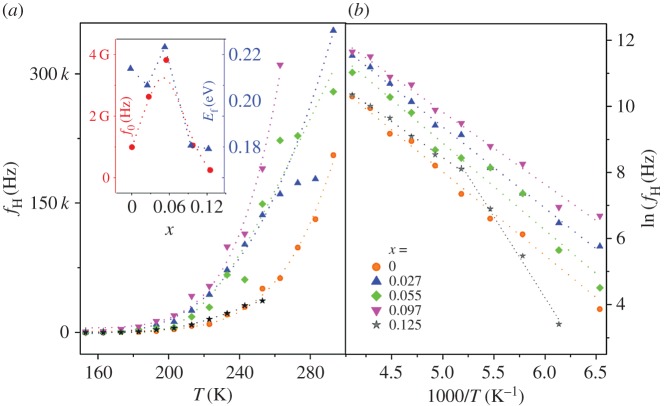
Temperature dependence of (a) hopping frequency, fH versus T and (b) log(fH) versus 1000/T for Cu1–xFexO (0 ≤ x ≤ 0.125). The dotted lines represent fitted spectra.